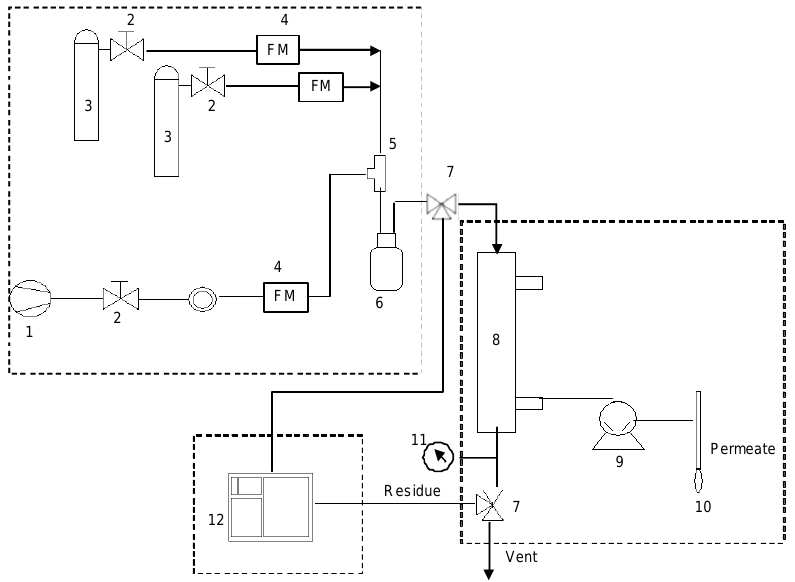
Figure 1. Schematic diagram of the experimental set up: (1) compressed air, (2) regulating valves, (3) gas cylinders, (4) flow meters (FM), (5) T connector, (6) mixing flask, (7) three way valves, (8) membrane module, (9) vacuum pump, (10) bubble flow meter, (11) pressure indicator, (12) gas chromatography equipment.